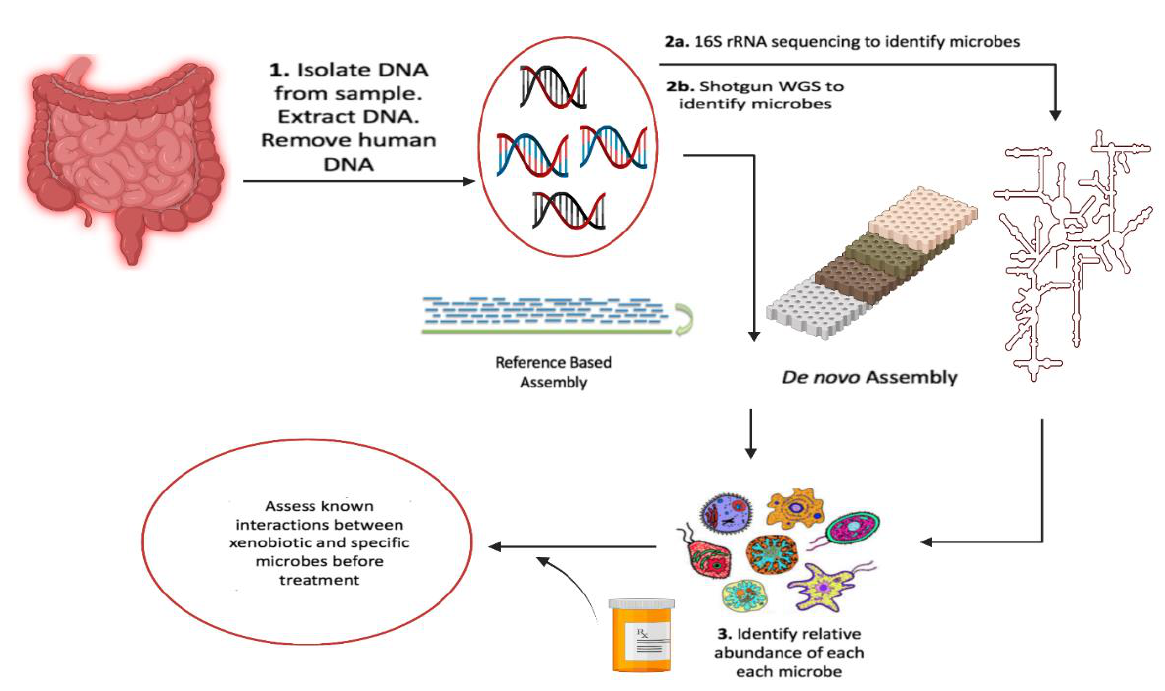
Figure 2. A typical pharmaco-microbiomic pipeline for the determination of appropriate xenobiotic prescriptions (image made by Biorender). A DNA from microbial samples is isolated, while rRNA is sequenced for microbes and aligned to microbial databases’ sequences. The proper xenobiotic prescriptions can be determined based on these interactions.